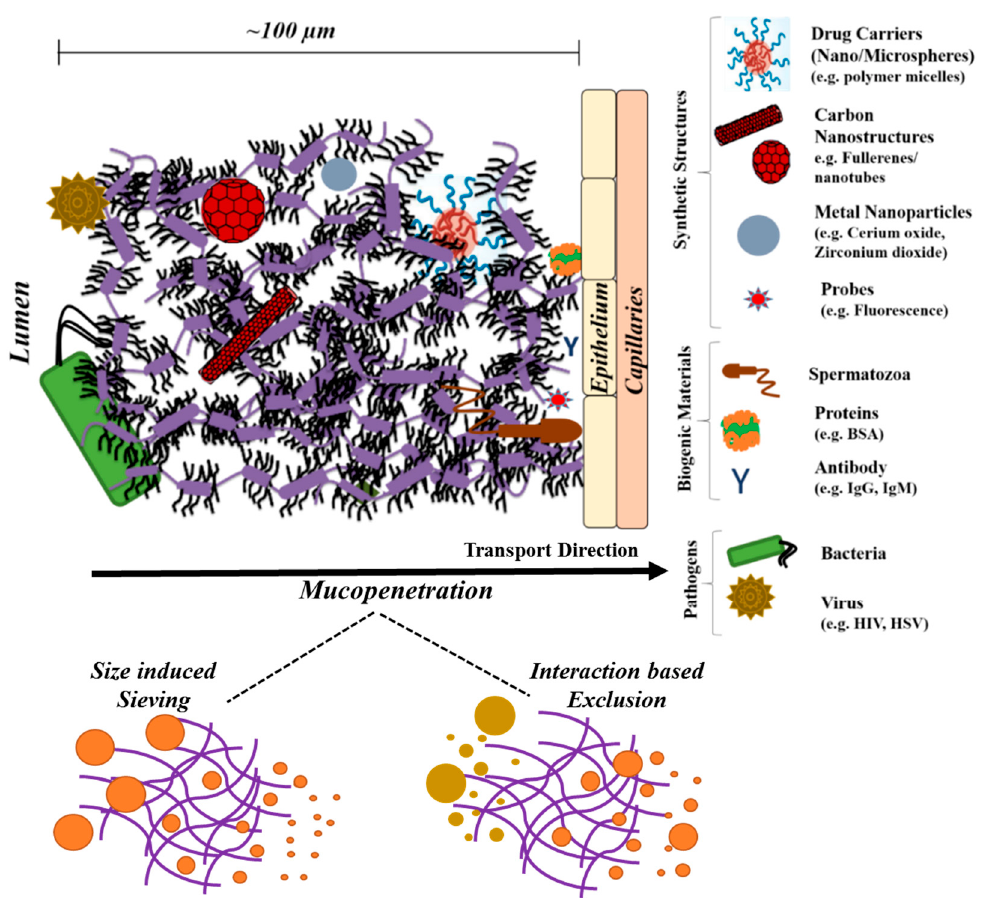
Figure 5. Schematic of mucin network’s (cervical region) ability to impact transport properties of various biogenic materials, synthetic structures or pathogens across its physical barrier. Figure also illustrates the mucopenetration effects, which can arise as a result of differences in network mesh size, or its adhesive interactions with transport molecules. Figure was adapted from References [105,106].